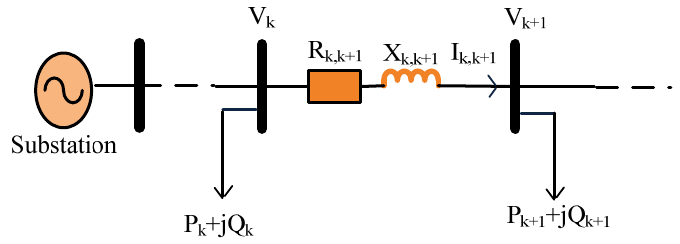
Figure 1. Two-bus equivalent of a distribution network.